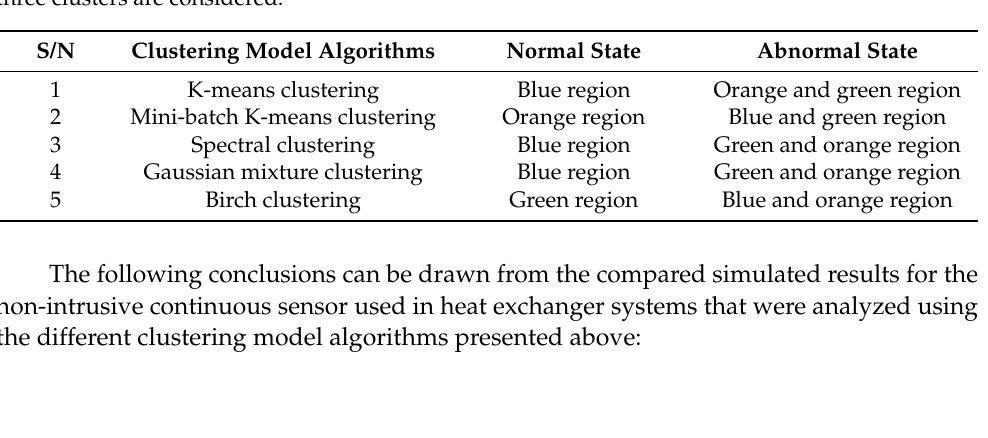
Figure 6. Simulated results for three clusters showing states of the sensor for the algorithms: mini- batch K-means clustering ( A ), spectral clustering ( B ), Gaussian mixture clustering ( C ), and birch clustering ( D ). Table 3. Comparison of the simulated results for the different clustering model algorithms when three clusters are